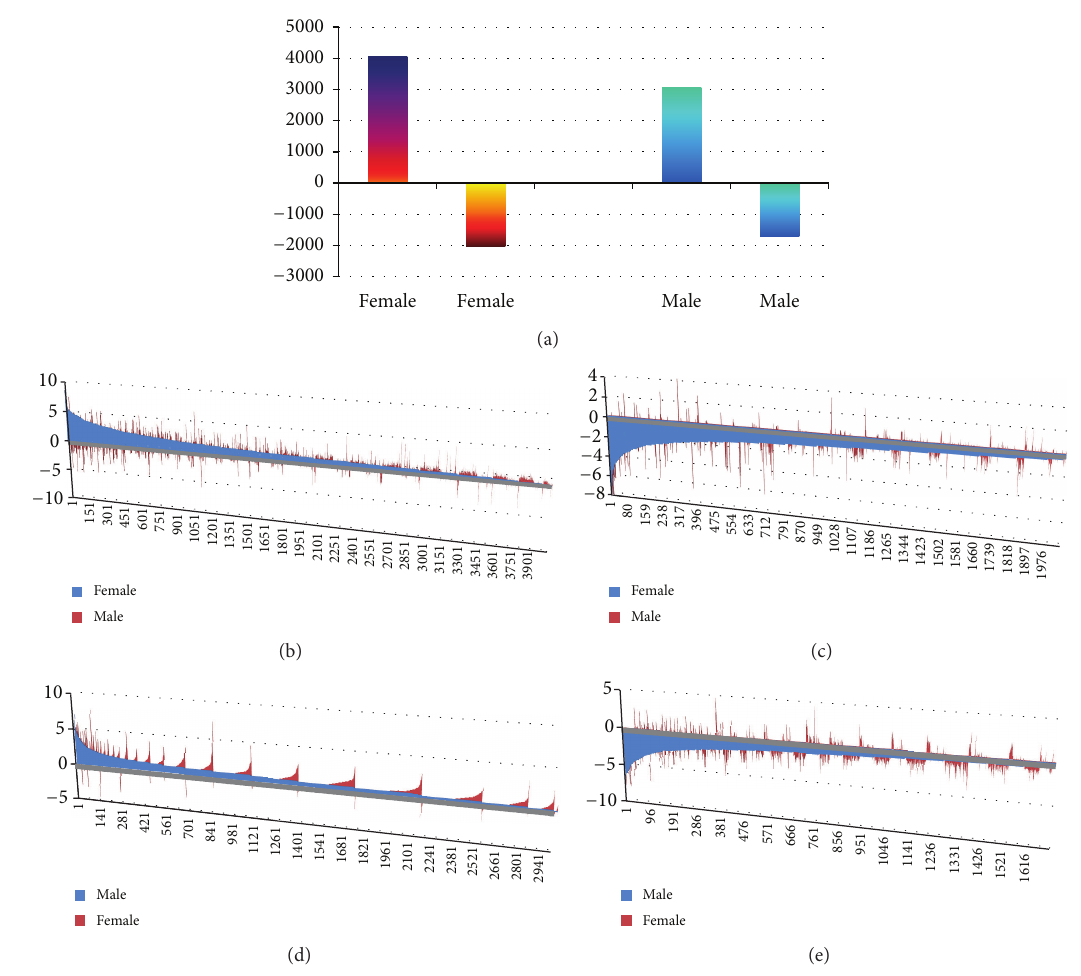
Figure 2: Genes are up- and downregulated in sfx mice. (a) shows the number of genes that are up- and downregulated by Gulo in female and male mice. 𝑌 axis in (b), (c), (d), and (e) indicates the fold changes of expression level in sfx mice. 𝑋 axis indicates the order number of genes shown in each figure. (b) shows the upregulated genes in sfx female (shown in Blue color) and their expression level in male mice (In red color). (c) shows the downregulated genes in sfx female (shown in Blue color) and their expression level in male mice (in red color). (d) shows the upregulated genes in sfx male (shown in blue color) and their expression level in female mice (in red color). (e) shows the downregulated genes in sfx male (shown in blue color) and their expression level in female mice (in red color).